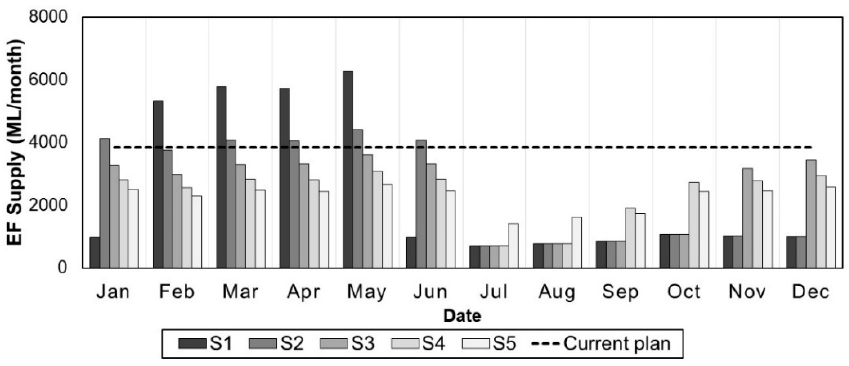
Figure 7. Variations of monthly EF supply by the scenarios.